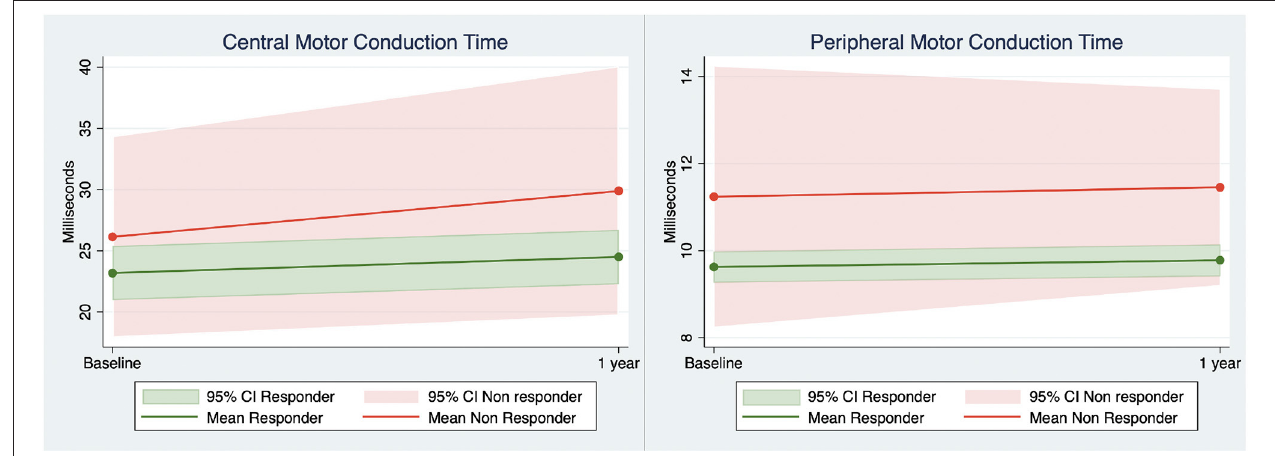
FIGURE 3 | Central and peripheral motor conduction (vastus medialis muscle) derived from transcranial magnetic stimulation elicited motor evoked potentials in responders and non-responders to Fampridine treatment at baseline and 1-year follow-up. 95% CI, 95% confidence interval.